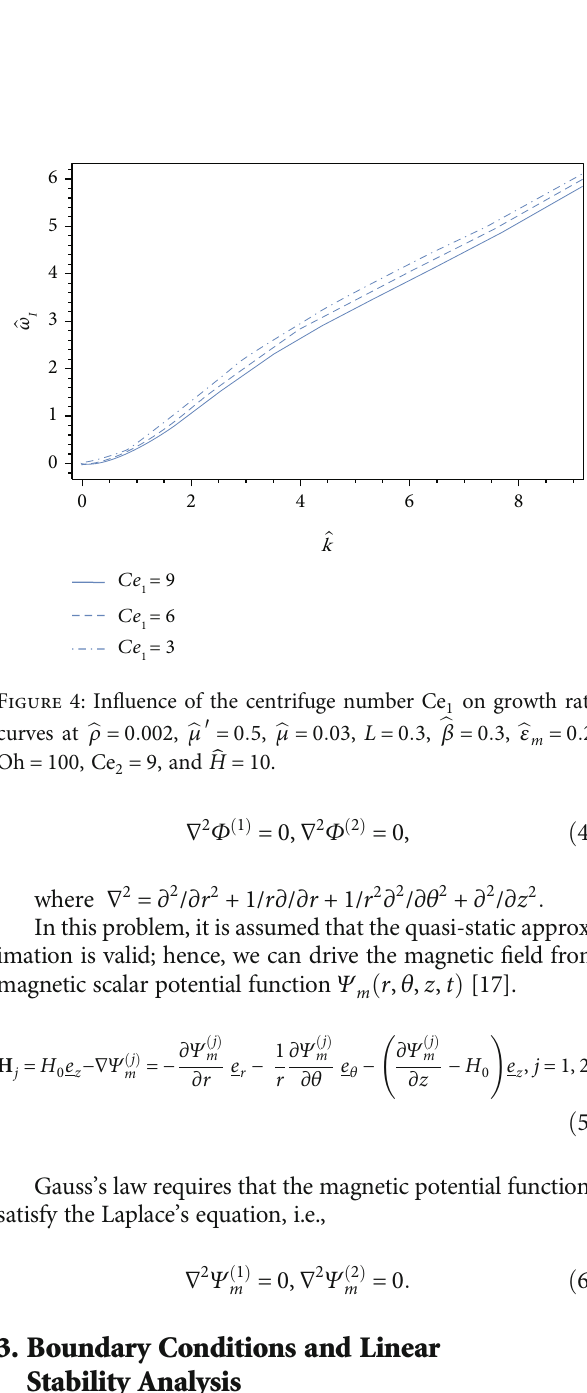
b β = 0 : 6 , b ε m = 0 : 3 , Ce 2 = 3 ,